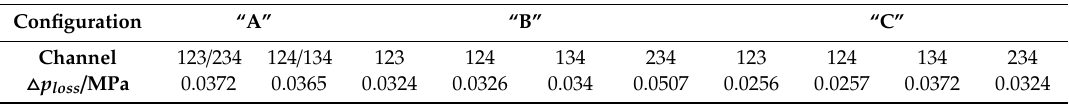
Table 7. Pressure losses of “A” “B” and “C” configurations with di ff erent channel combinations under three parallel channel